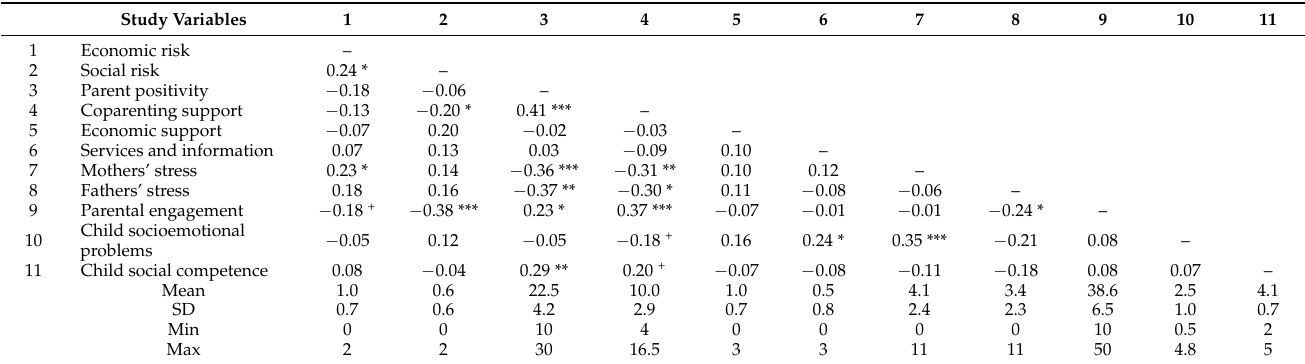
Table 3. Zero-order correlations for predictors, moderators, and outcomes.